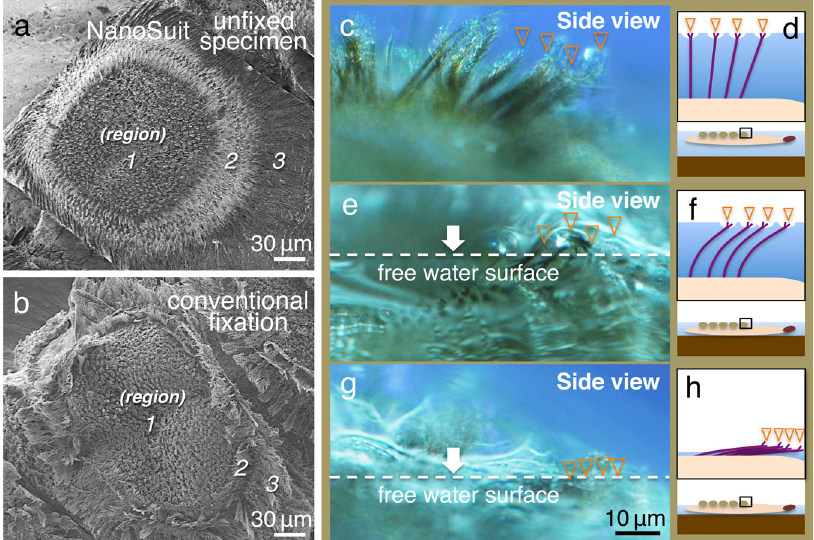
Fig 3 Hairy structures in the crown show fl exible property. a , b SEM images of the crown structure treated either using the NanoSuit method in a or prepared by conventional fi xation methods in b . Note that for the sample prepared using the NanoSuit living-specimen method, upon being pulled out of the water, hairy structures were observed to droop down, suggesting that they were fl exible. In contrast, for the sample prepared using conventional fi xation methods, the hairy structures appeared to have been dried out by the various pre-treatments. c , e , g Optical microscopy and d , f , h corresponding schematic images of the hairy structures in the crown responding to the water surface at different heights. The overlaid orange arrowheads indicate the positions of the tips of the hairy structures. The fl exible structures bend when the surface of the water is below the tips, and the underside of the body is in contact with the bottom of the container.